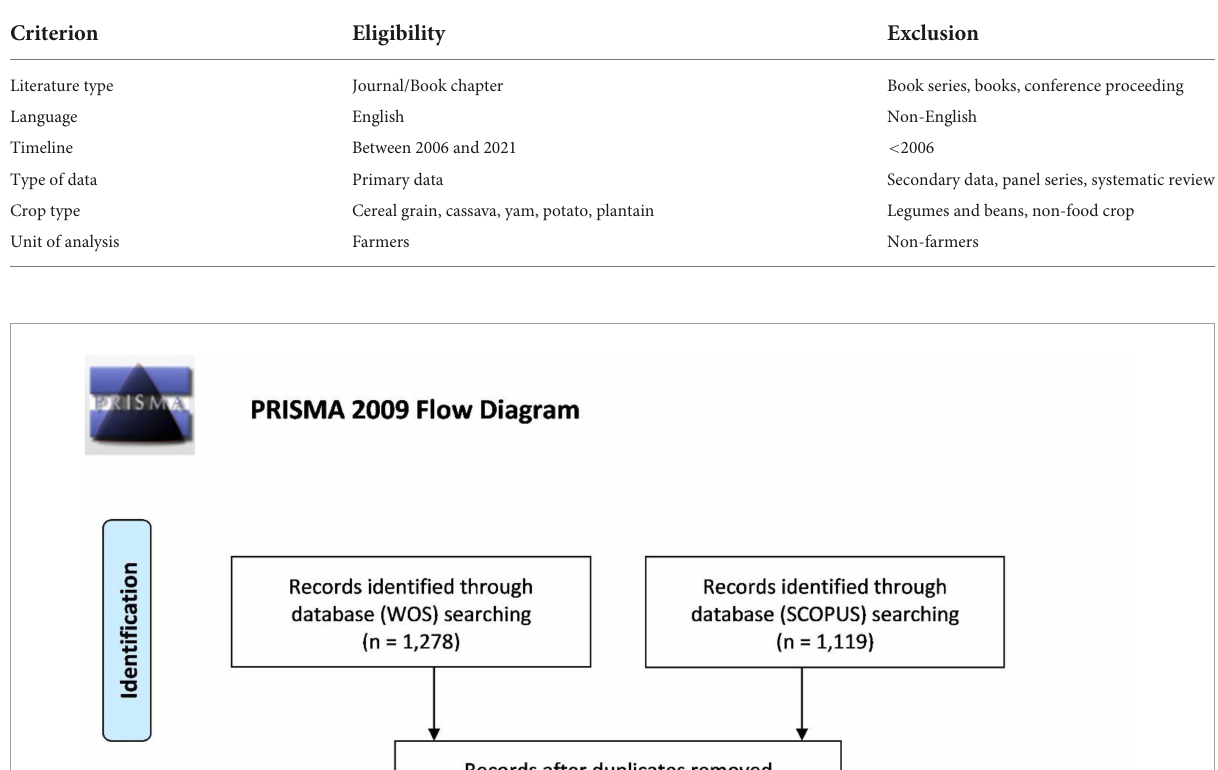
TABLE 2 Protocol inclusion and exclusion criteria.